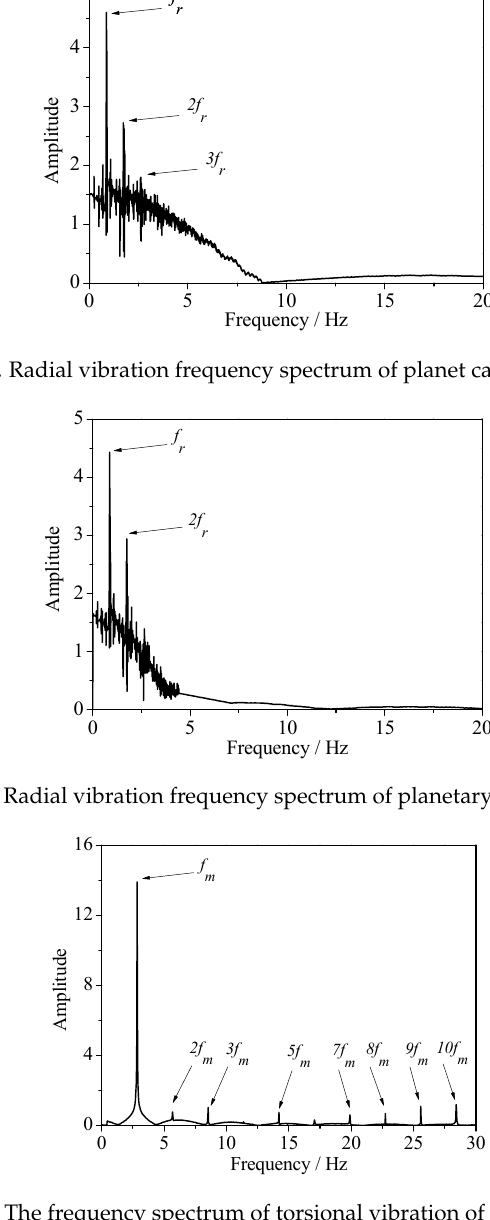
Figure 6. The frequency spectrum of torsional vibration of planet carrier.